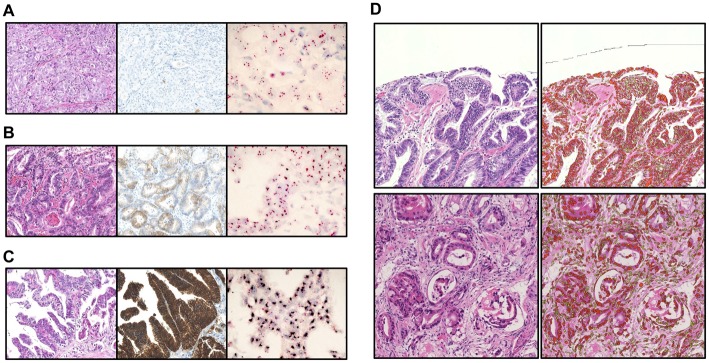
Histological analysis of clinical gastric cancer biopsy specimens and estimation of TCR using Tissue Studio.(A–C) Representative cases are shown with HE staining, HER2-IHC, and HER2-DISH. (A) Case #37: HER2-IHC score = 0, HER2-DISH ratio = 1.09. (B) Case #6: HER2-IHC score = 2+, HER2-DISH ratio = 2.83. (C) Case #25: HER2-IHC score = 3+, HER2-DISH ratio = 6.56. (D) TC rate was calculated based on the ratio of nuclei counts of whole nucleated and cancerous cells, which were semi-automatically distinguished by nucleus size—with cancerous cells showing enlarged nuclei—by means of Tissue Studio image analysis software.